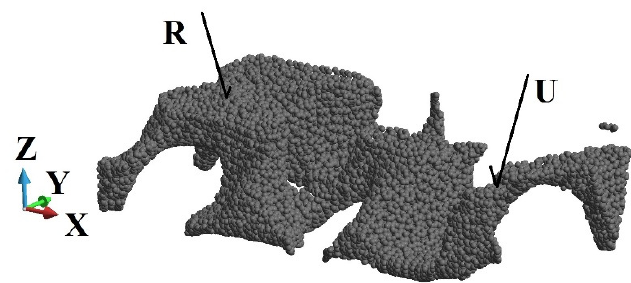
Figure 7. Observed points at cross-section A-A (Figure 5b).